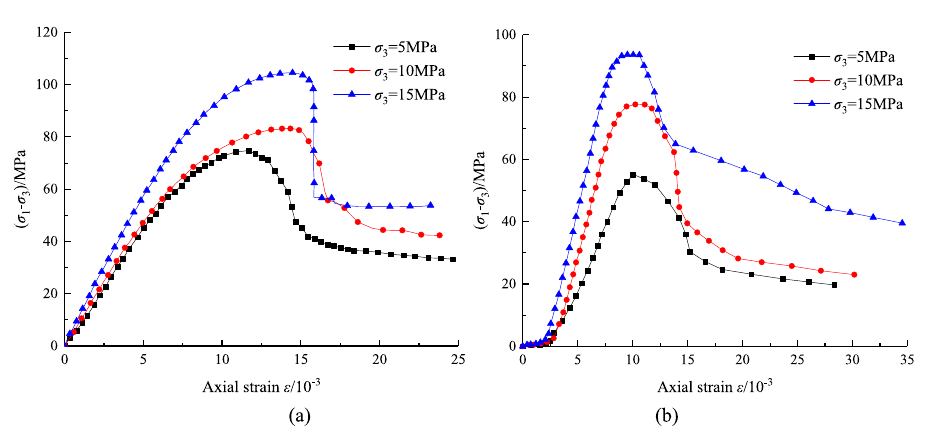
Figure 4. Stress–strain curves : ( a ) loading, ( b )